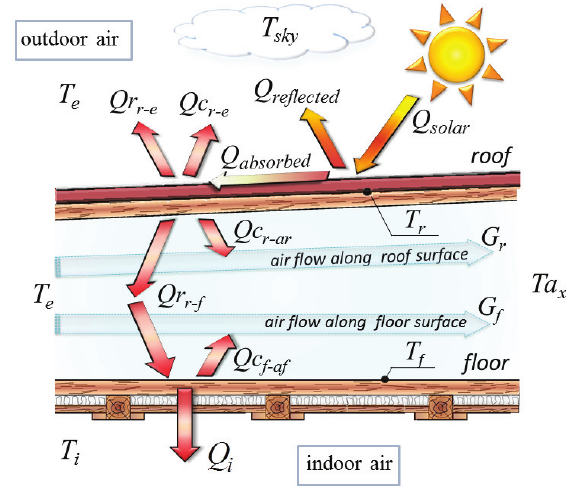
Fig. 8. Scheme of the heat flows in the attic under summer conditions